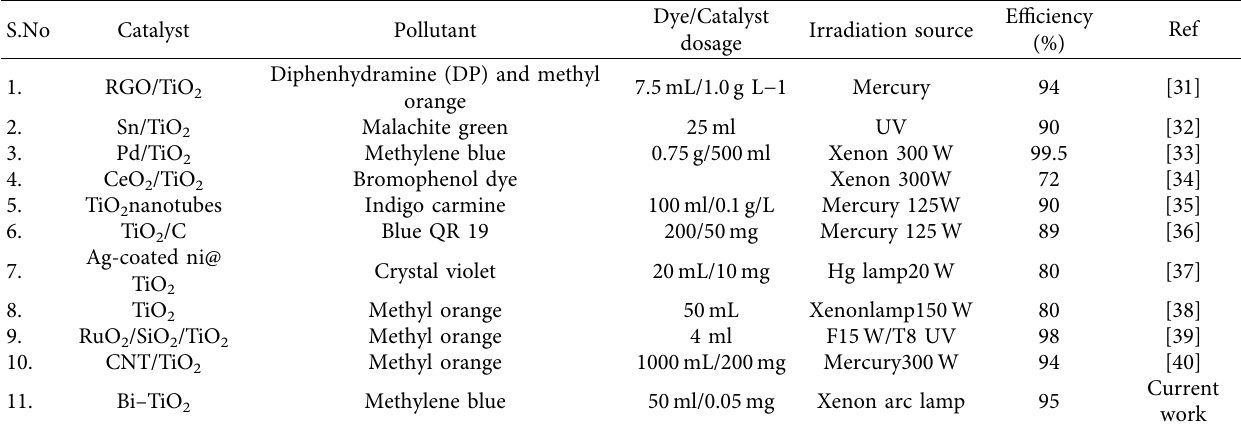
Table 3: Comparison with collected work